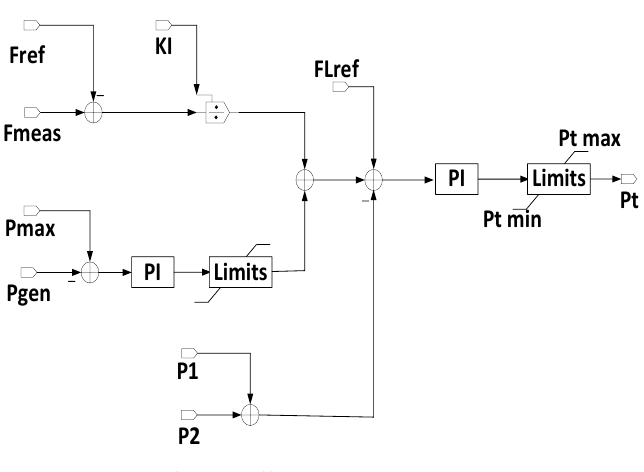
Figure 4. IFC mode controller.